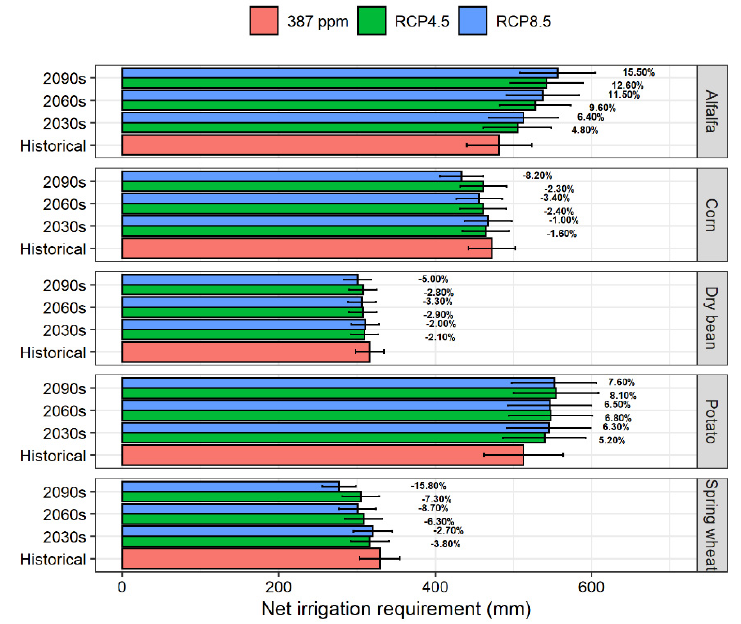
Figure 9. Historical and future net irrigation requirements for alfalfa, corn, dry bean, potato, and spring wheat. Results are for fixed planting date and transient CO 2 concentration under both RCP. Numbers associated with each bar correspond to percent change with respect to historical values.